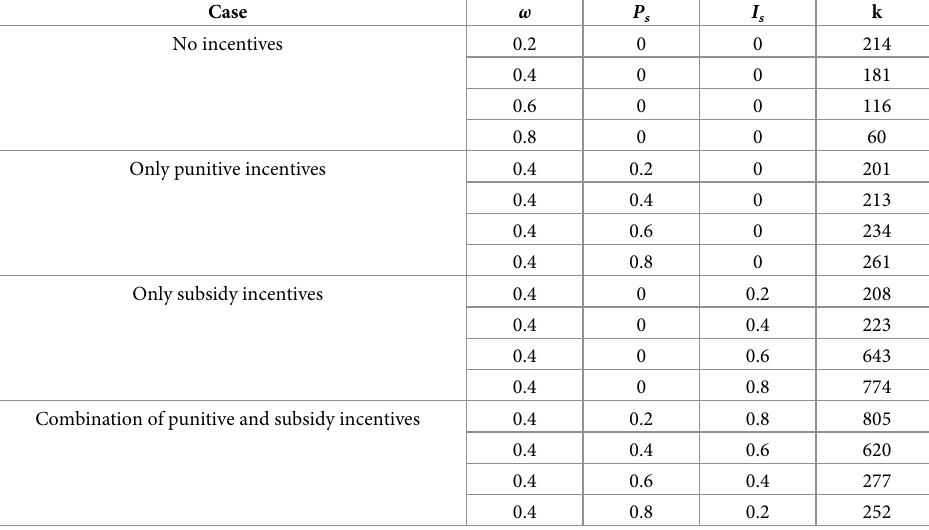
Table 2. Simulation results for different incentives (Data: